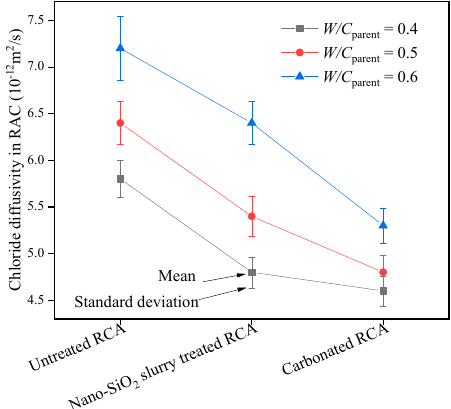
Figure 9. The value of D RAC with different types of RCAs.